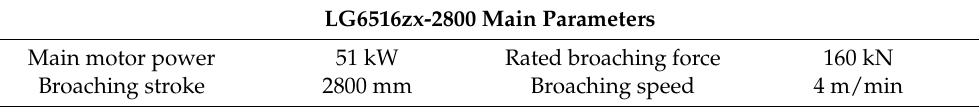
Table 3. Main parameters of horizontal broaching machine LG6516zx-2800.